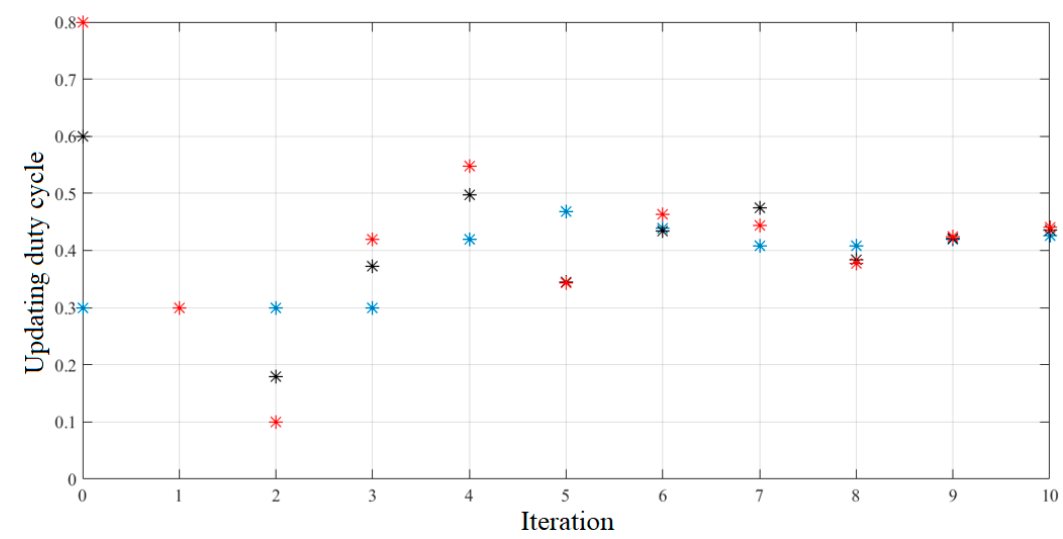
Figure 13. Updating of boost converter duty cycle for each iteration.